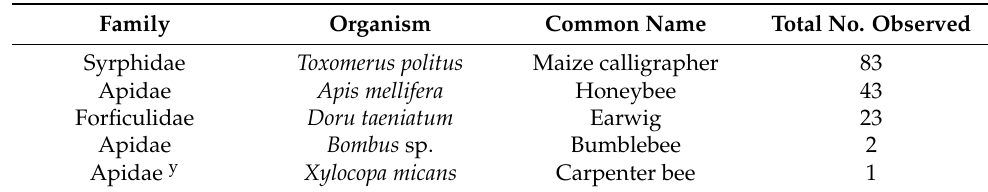
Table 1. Insects observed collecting or consuming pollen on a sweet sorghum population over four rating dates in September–October 2021. Family Organism Common Name Total No. Observed Syrphidae Toxomerus politus Maize calligrapher 83 Apidae Apis mellifera Honeybee 43 Forficulidae Doru taeniatum Earwig 23 Apidae Bombus sp. Bumblebee 2 Apidae y Xylocopa micans Carpenter bee 1